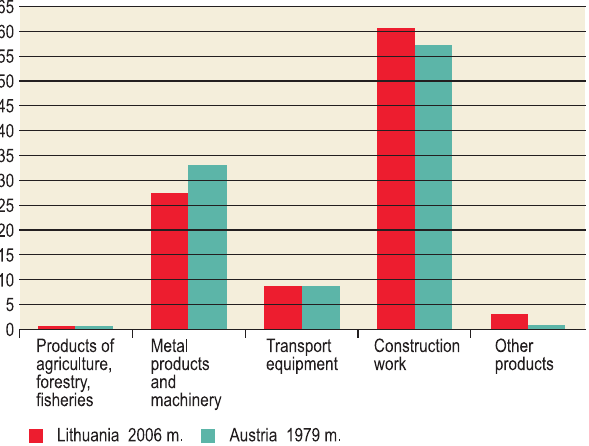
Fig. 5. Juxtaposition of current Lithuanian fi xed investment structure and Austria’s in the year